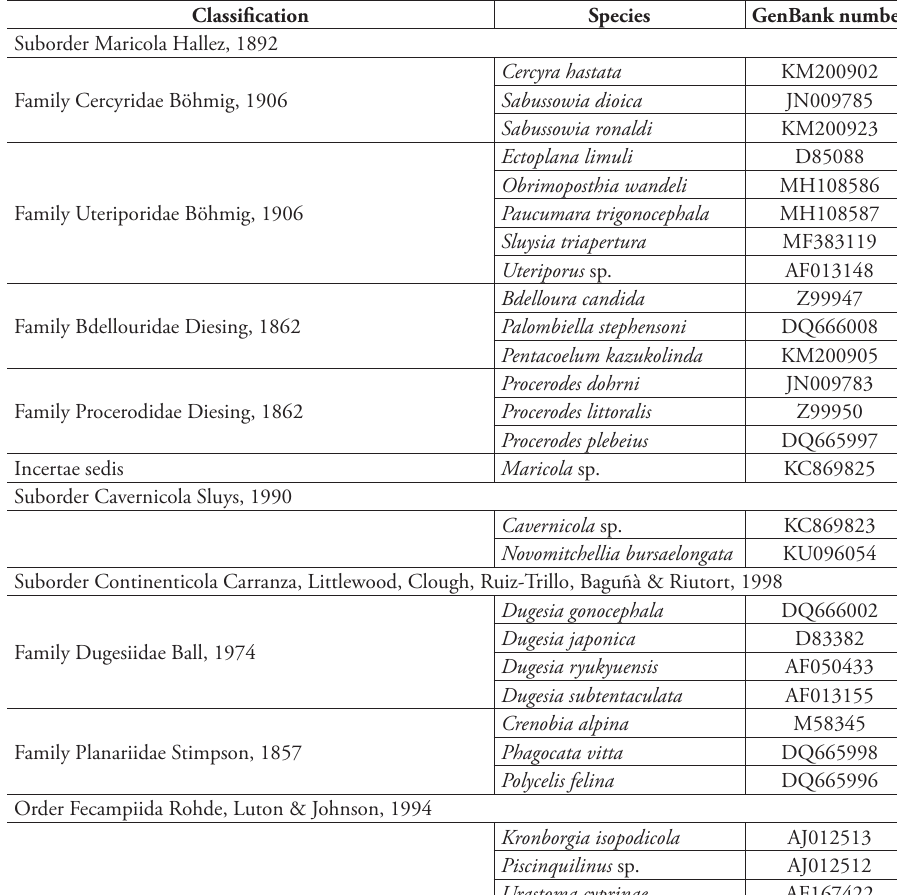
Table 1. List of species taxa of which 18S rDNA gene data was used for constructing the phylogenetic trees, with accession numbers for gene sequences available from